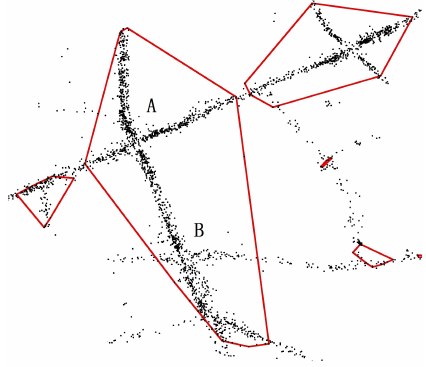
Figure 1. The DBSCAN of trajectory points at intersections The discontinuity of floating vehicle trajectory data leads to the discrete distribution of trajectory points in road network and it is impossible to directly and precisely judge which intersection nearby the trajectory points belong to on the basis of the location of trajectory points only. In particular, when